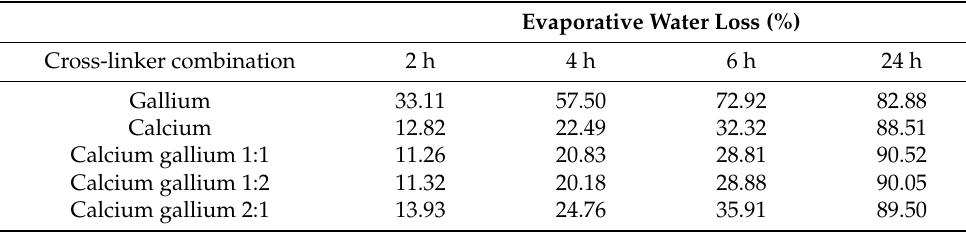
Table 2. Changes in average evaporative water